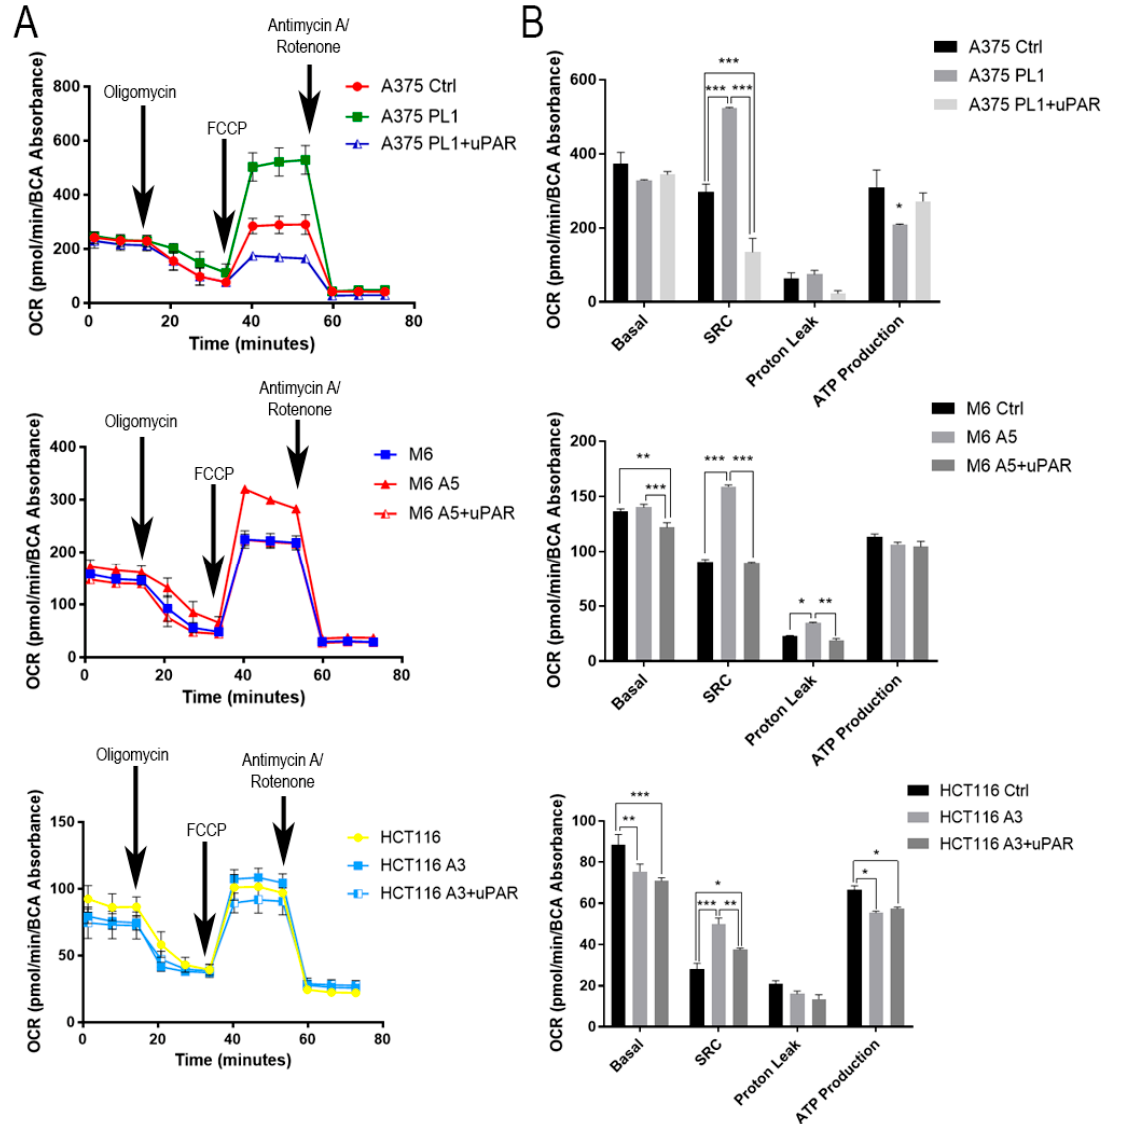
Figure 6. The Mitostress assay was performed as described in “Results.” Oxygen Consumption Rate (OCR) ( A ) measured in Seahorse Mitostress assays is shown as traces from a representative Seahorse run. ( B ) The average of the three measures after the exposure to the above described drugs is summarized in histograms. Here are the summarized results from at least three independent biological experiments, each consisting of independent cell plating on five Seahorse microplate wells. Data are presented as mean ± SD. * p < 0.05; ** p < 0.01; *** p < 0.001 relative to Control (One-way ANOVA test).